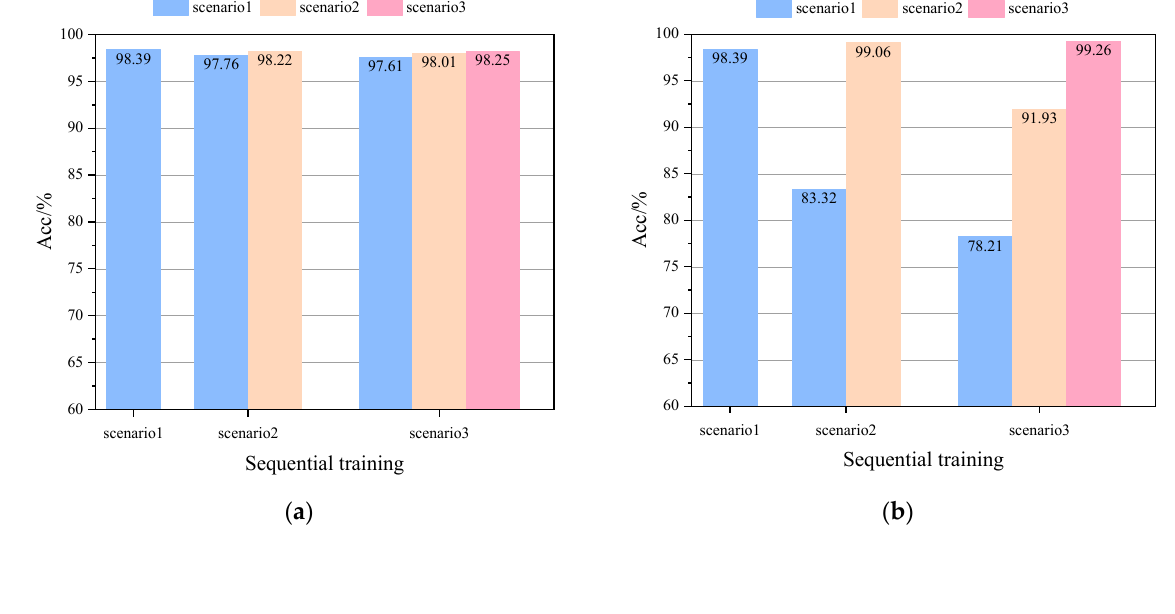
( c ) Figure 12. Acc comparison of two different update schemes on the IEEE 118-bus system: ( a ) Acc comparison of FT-DRSN in different scenarios, ( b ) Acc comparison of SCP-DRSN in different scenarios, and ( c ) Acc comparison in all seen scenarios. Table 4. Performance of different models on the IEEE 118-bus system with different SNRs.